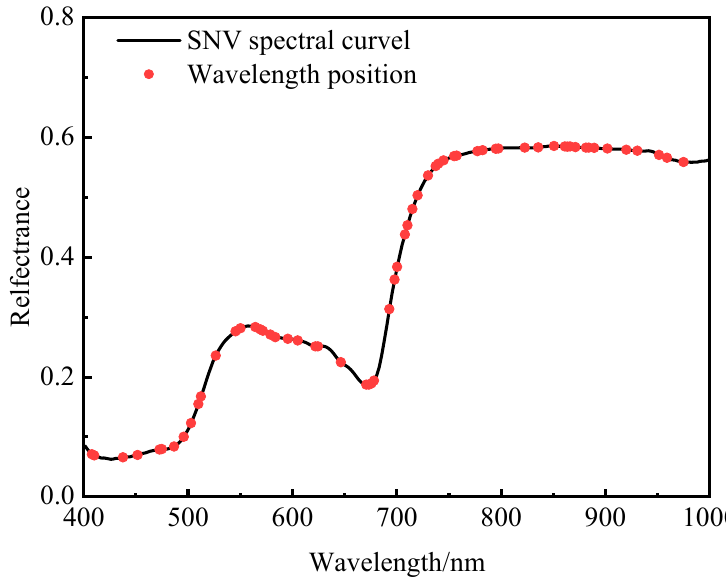
Figure 9. Characteristic wavelengths of the SNV spectral curve selected using the PSO algorithm.